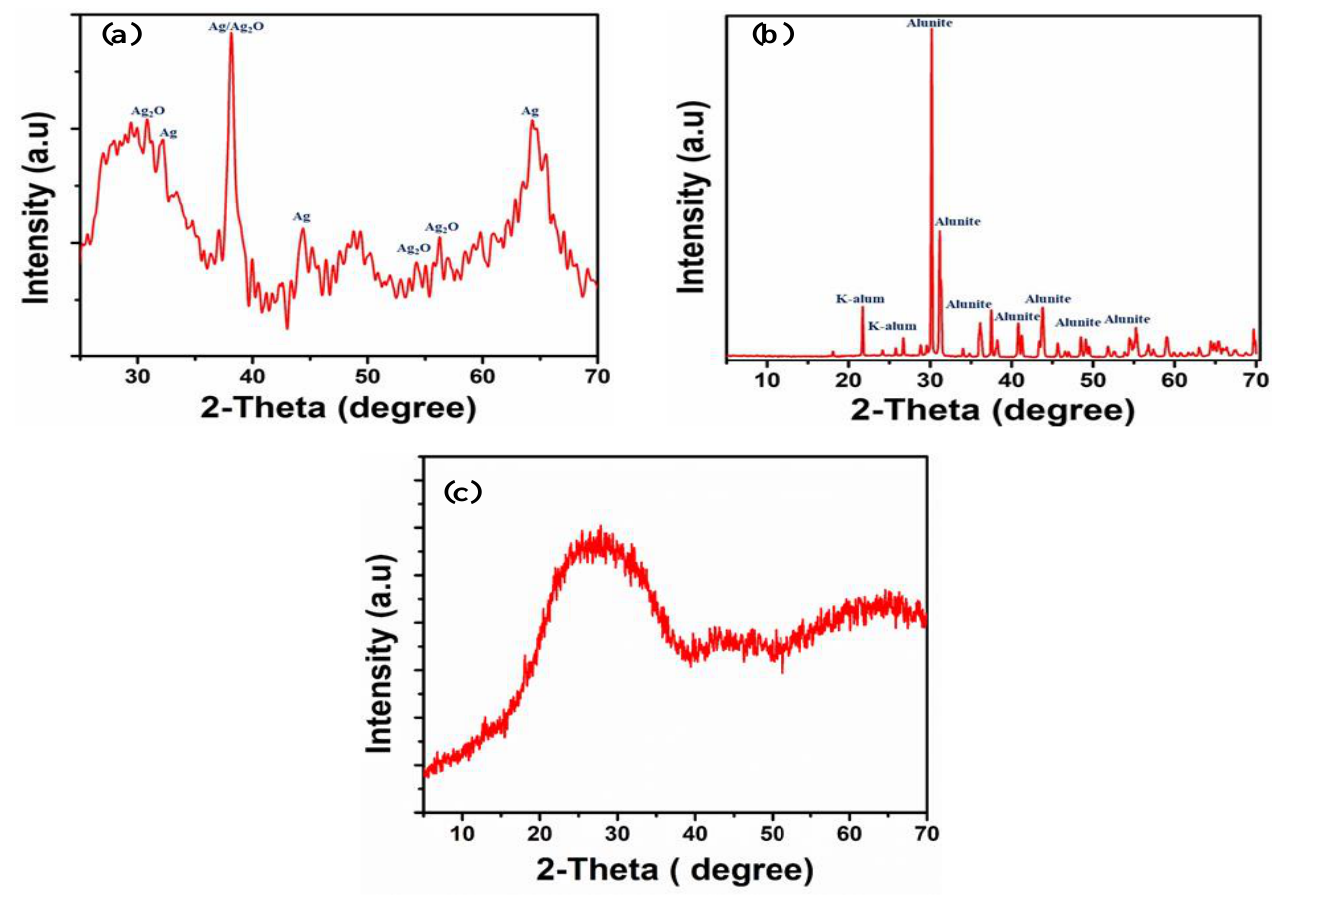
Figure 3. X-ray diffraction patterns of synthesized materials: ( a ) for Ag/Ag 2 O mixture, ( b ) for alunite/K-alum mixture, and ( c ) for amorphous silica.